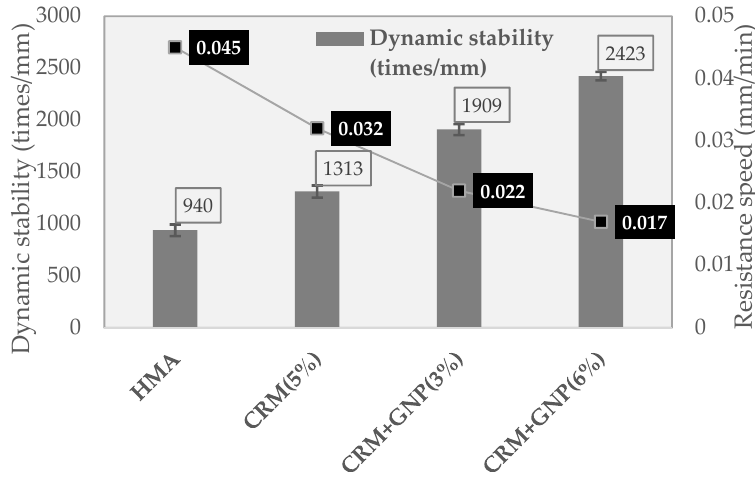
Figure 12. Dynamic stability based on the HWT test.